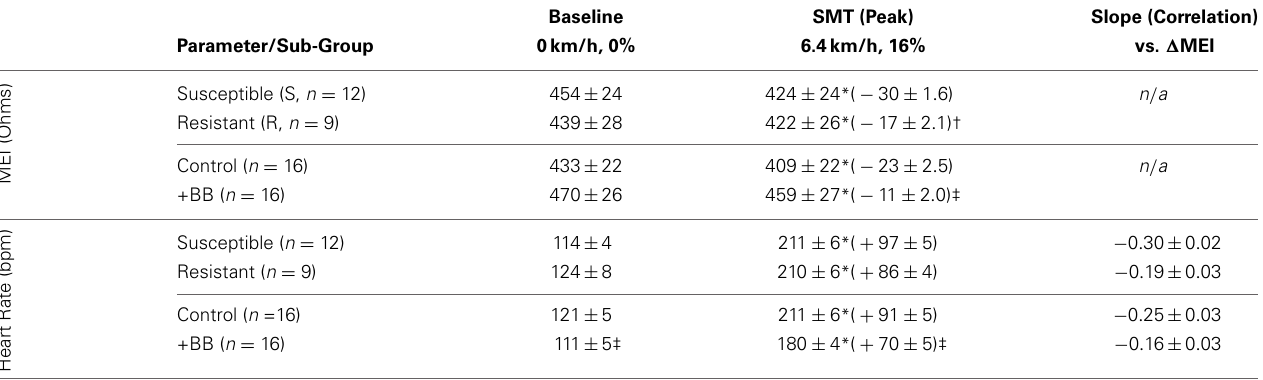
Table 2 | Exercise-induced changes in both the myocardial electrical impedance (MEI) and the heart-rate (HR) of awake-unsedated dogs with healed left-anterior descending (LAD) myocardial infarct; comparative effects of the underlying susceptibility to malignant arrhythmias (S vs. R), and of β -adrenoceptor blockade